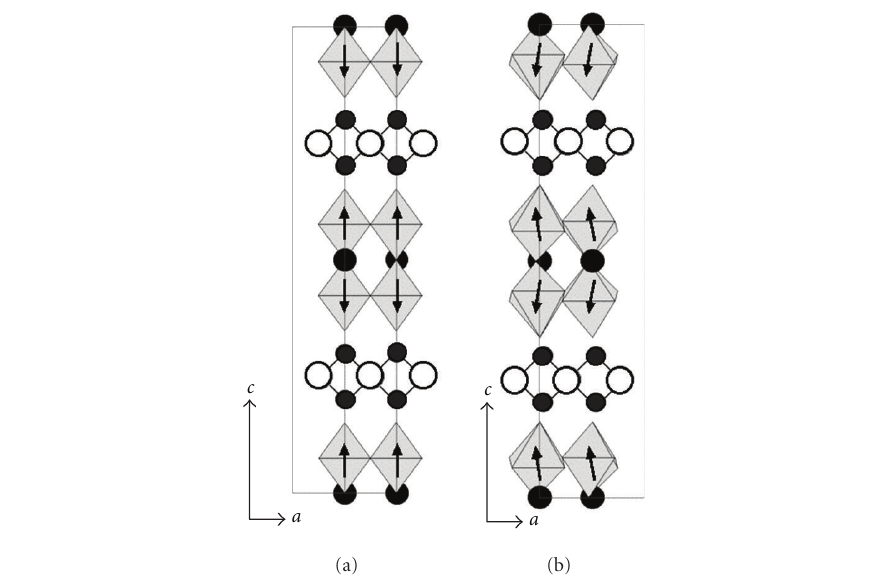
Figure 12: Crystal structures of (a) the paraelectric and (b) the ferroelectric phases of layered perovskite SrBi 2 Ta 2 O 9 . Arrows show estimated dipole arrangements of TaO 6 octahedra